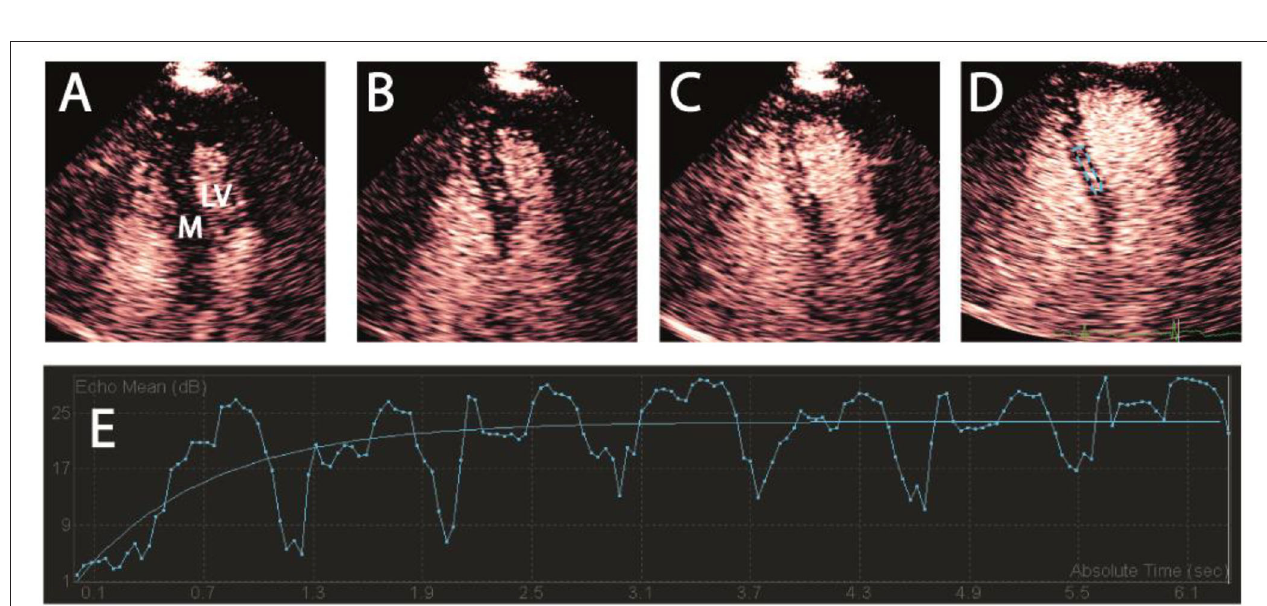
FIGURE 3 | Myocardial contrast echocardiography. Contrast-enhanced transthoracic apical 4-chamber view end-systolic. After microbubble destruction with a high MI-pulse, replenishment of contrast is visible in the myocardium. (A–C) Subsequent replenishment of myocardial contrast, (D) ROI in the myocardial septum, (E) Example of myocardial replenishment in a time-video intensity curve. Fluctuations in the myocardial blood volume during replenishment, as demonstrated in this figure, is caused by the cardiac cycle of systole and diastole. MI, mechanical index; ROI, region of interest; M, myocardial; LV, left ventricle.